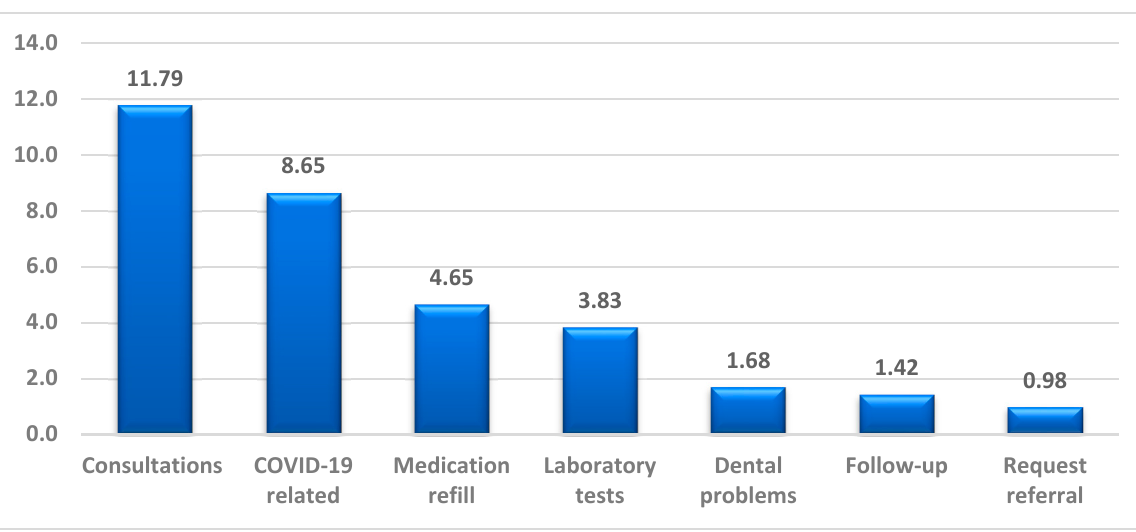
Figure 1. Top reasons for seeking telehealth visits at DHA from March 2020 to July 2021